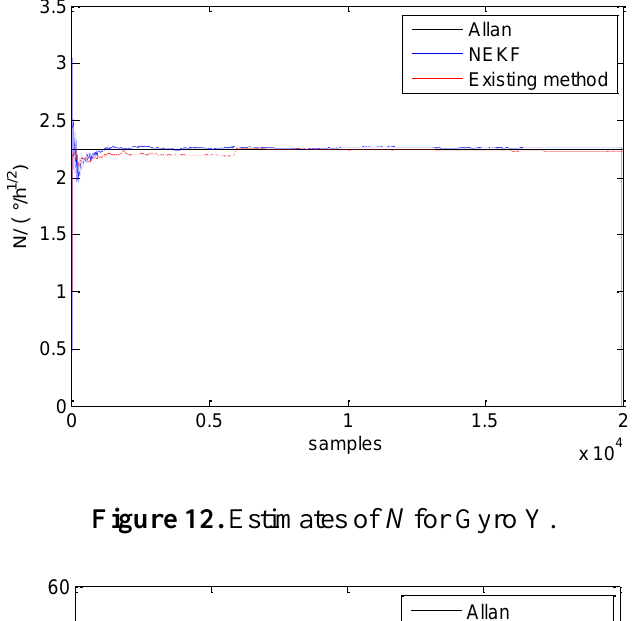
Figure 11. Estimates of K for Gyro X.